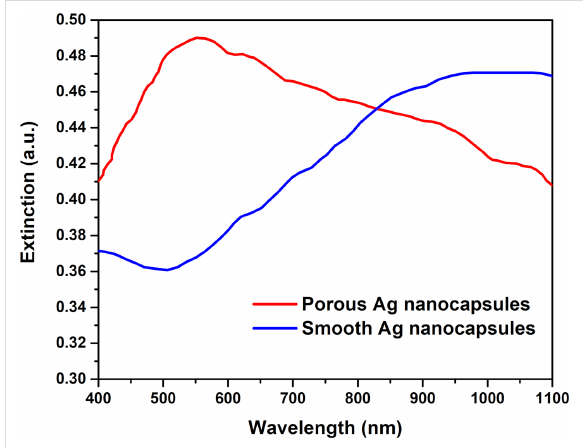
Figure 6: UV–vis spectra of porous silver nanocapsules with hydrogel cores ( ≈ 930 nm in diameter) and complete silver nanocapsules with hydrogel cores ( ≈ 920 nm in